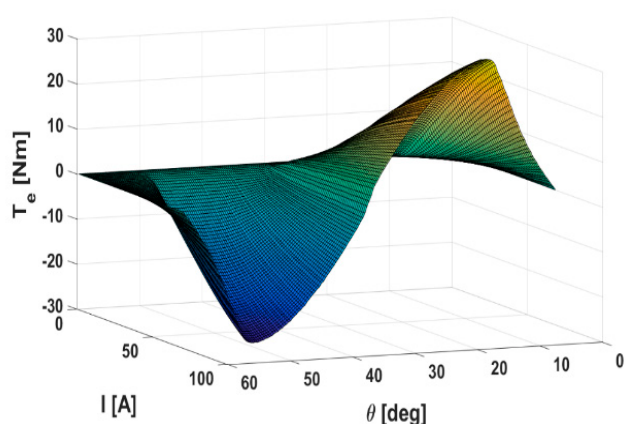
Figure 2. Torque in terms of position and phase current.